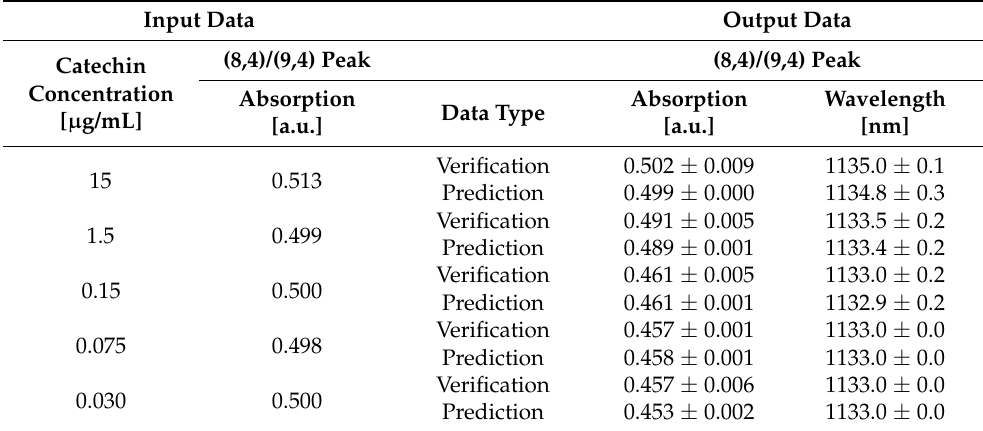
Figure 4. ( a ) Comparison of prediction data and verification data of absorption peak of (8,4)/(9,4) DNA-SWCNTs. ( b ) Comparison of prediction data and verification data of peak wavelength of (8,4)/(9,4) DNA-SWCNTs. Each value is expressed as mean ± standard deviation. Table 1. Absorption and wavelength of (8,4)/(9.4) peak in prediction data and verification data.